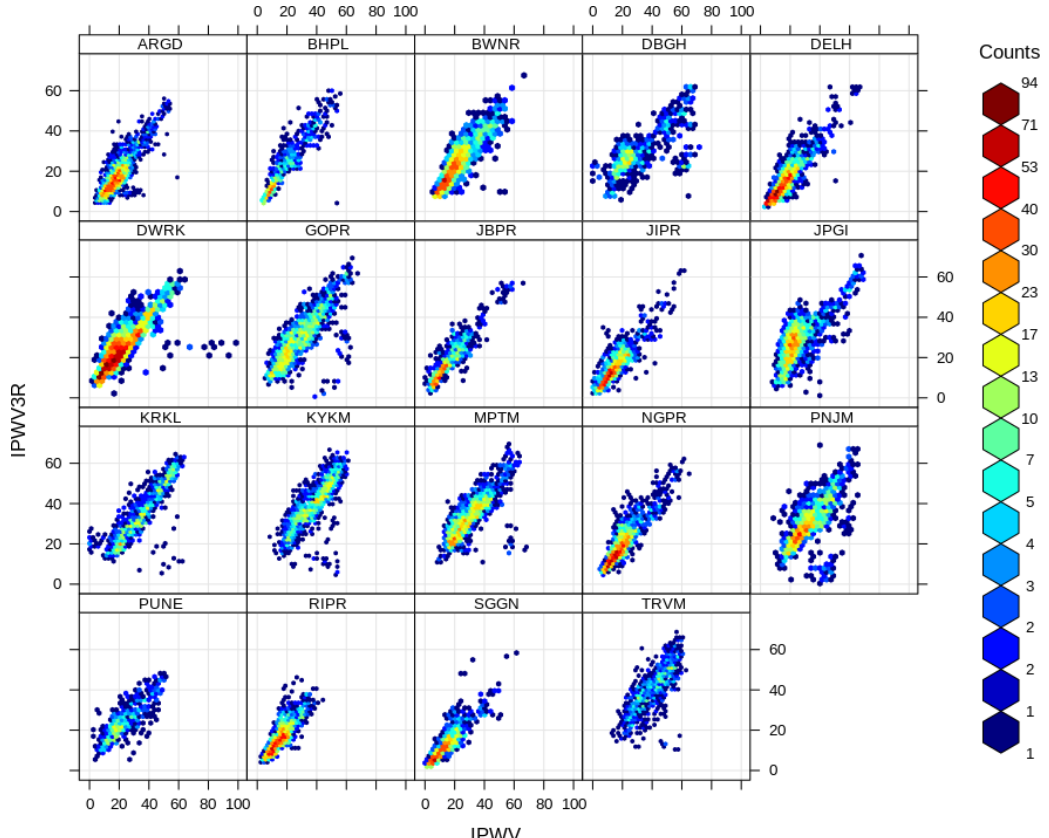
Figure 4. Scatter plot of hourly INSAT-3DR IPWV vs. GNSS IPWV using hexagonal binning.